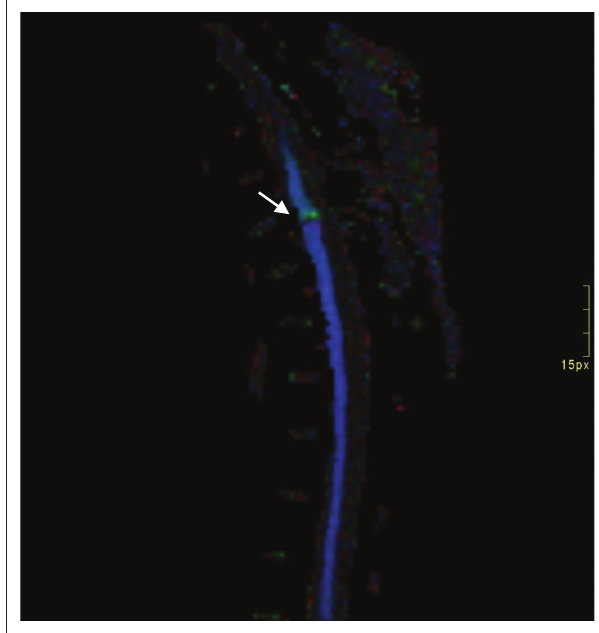
FIGURE 7: Sagittal diffusion tensor imaging of the thoracic spine demonstrates disrupted white matter tracts with decreased fractional anisotropy